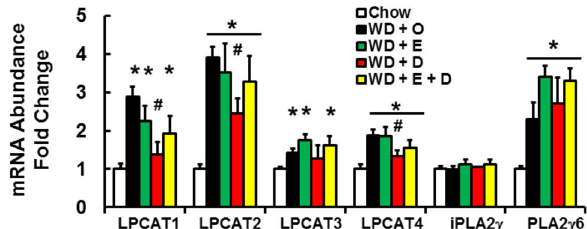
Figure 13. Diet effects on the expression of enzymes involved in membrane remodeling. Expression of enzymes involved in the incorporation of fatty acyl chains into phospholipids (lysophosphatidylcholine acyl transferase subtypes, LPCAT1-4) and excision of fatty acids from the sn-2 position of phospholipids (phospholipase A2 subtypes, iPLA2γ and PLA2γ6) were quantified. Results are represented as mRNA Abundance-Fold Change, mean ± SD; n=8/group; *, p ≤ 0.05 versus chow; #, p ≤ 0.05 versus WD + O.